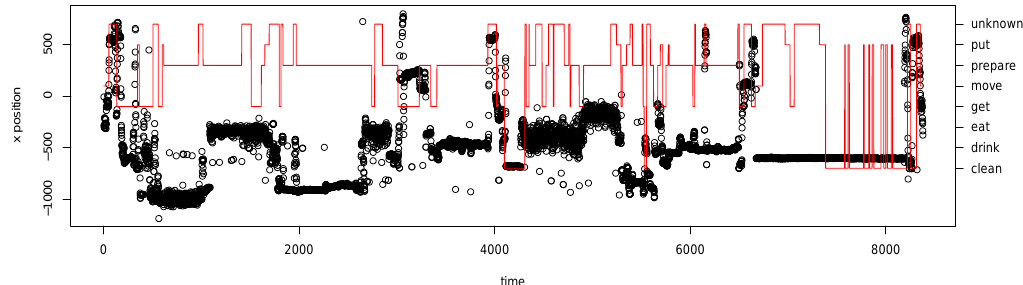
Figure 15. Example of the relationship between camera data and performed activity. The x-axis position extracted from the depth camera is given with black circles, while the annotated actions are given with red solid